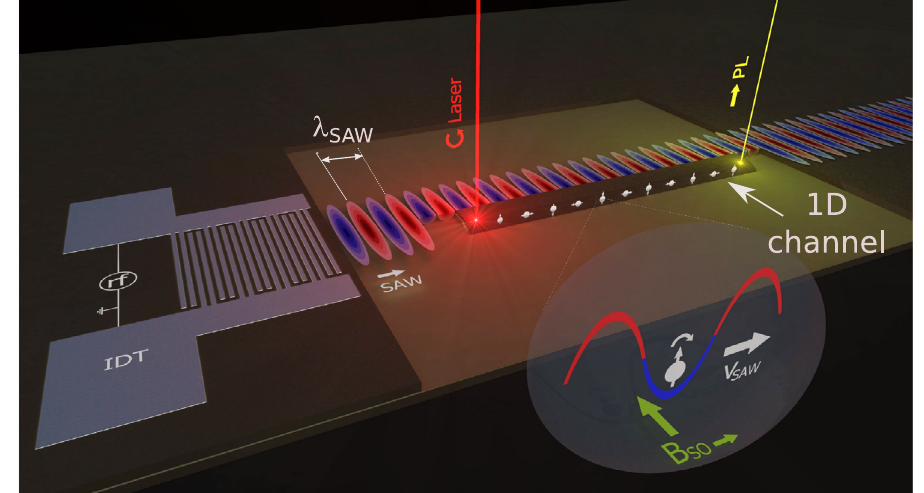
Fig. 1 | Flying control gate for electron spins. A surface acoustic wave (SAW) excited by an interdigital acoustic transducer (IDT) is applied along a quasi-one dimensional (1D) semiconductor channel. The piezoelectric potential of the SAW creates moving, quasi-zero dimensional (0D) potential dots, which capture spin- polarized electrons and holes excited by a circularly polarized laser beam and